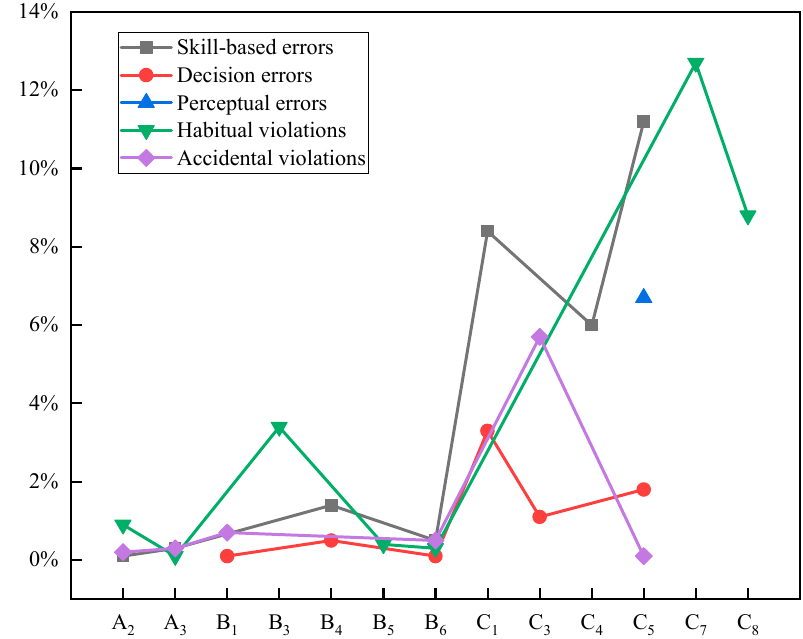
Figure 6. Sensitivity analysis result.